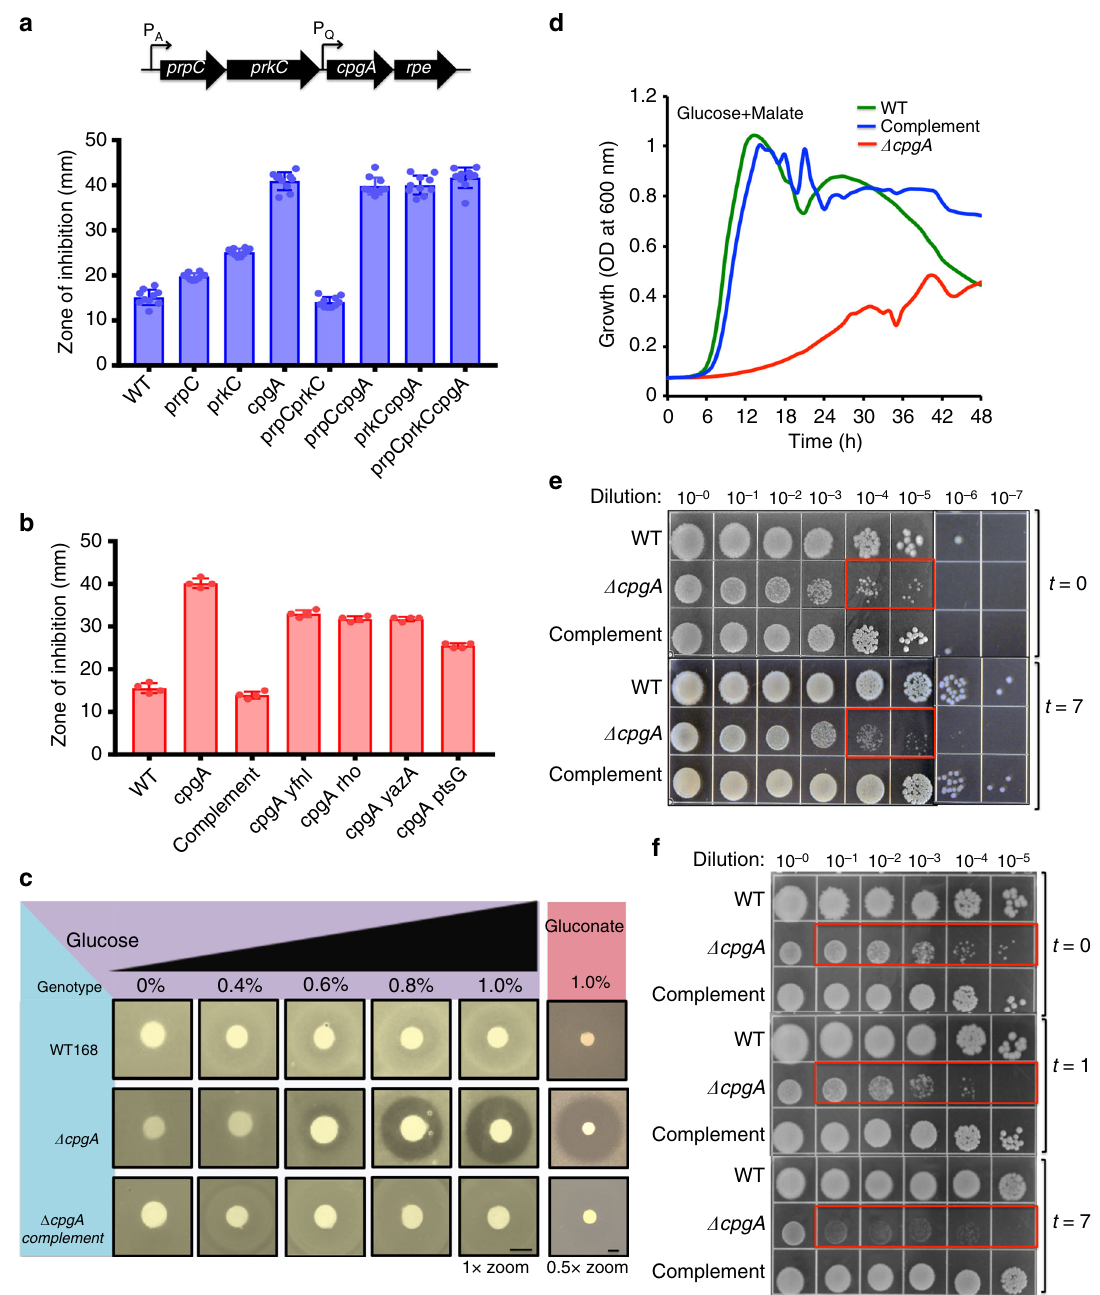
Fig. 2 A Δ cpgA mutant is intoxicated by glucose or gluconate. a Top panel: prpC-prkC-cpgA genomic locus organization and bottom panel: CEF sensitivity of the strains shown as measured for 6 μ g of CEF using a disk diffusion assay (8 mm diameter) performed on LB media ( n = 10). b The CEF sensitivity (shown as zone of inhibition, ZOI, mm) of the Δ cpgA strain can be partially suppressed by deletions in genes identi fi ed by mTn insertions ( yfnI , rho , yazA , and ptsG ) ( n = 3). The complemented strain ( Δ cpgA pMUTIN4- cpgA ) was at locus. Results shown are representative of three-independent